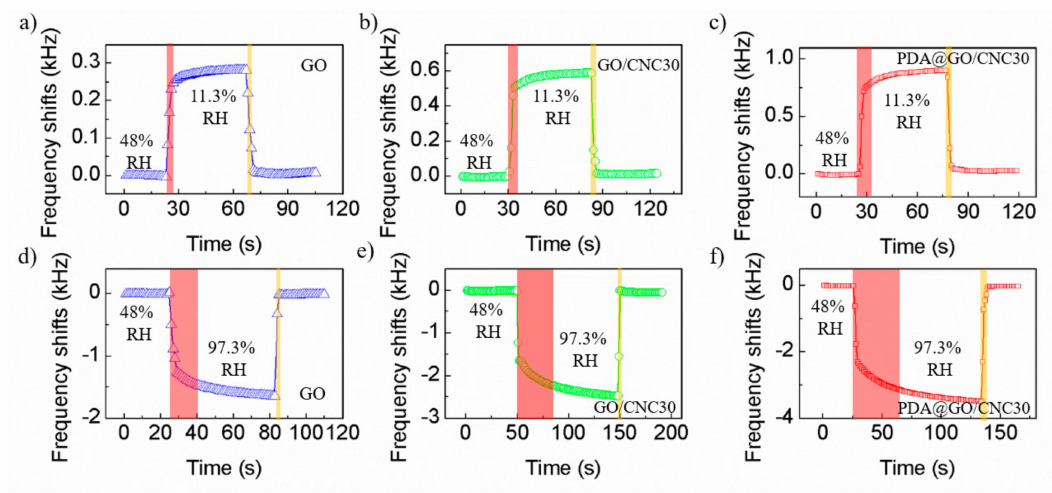
Figure 9. Dynamic response and recovery curves of ( a , d ) GO-, ( b , e ) CNC / GO30- and ( c , f